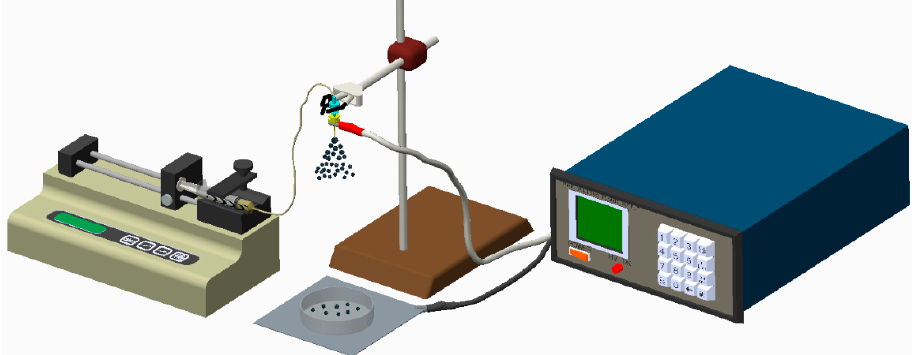
Figure 1. Schematic of the experimental setup to electrospray the drug-eluting